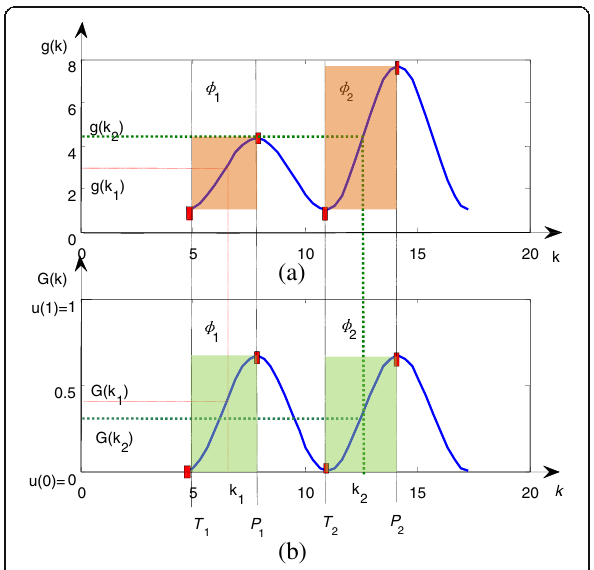
Fig. 2 The illustration of the 1D grayscale wave transformation. a The original grayscale wave curve g ( k ). b The wave transformation value G ( k ) of the curve g ( k